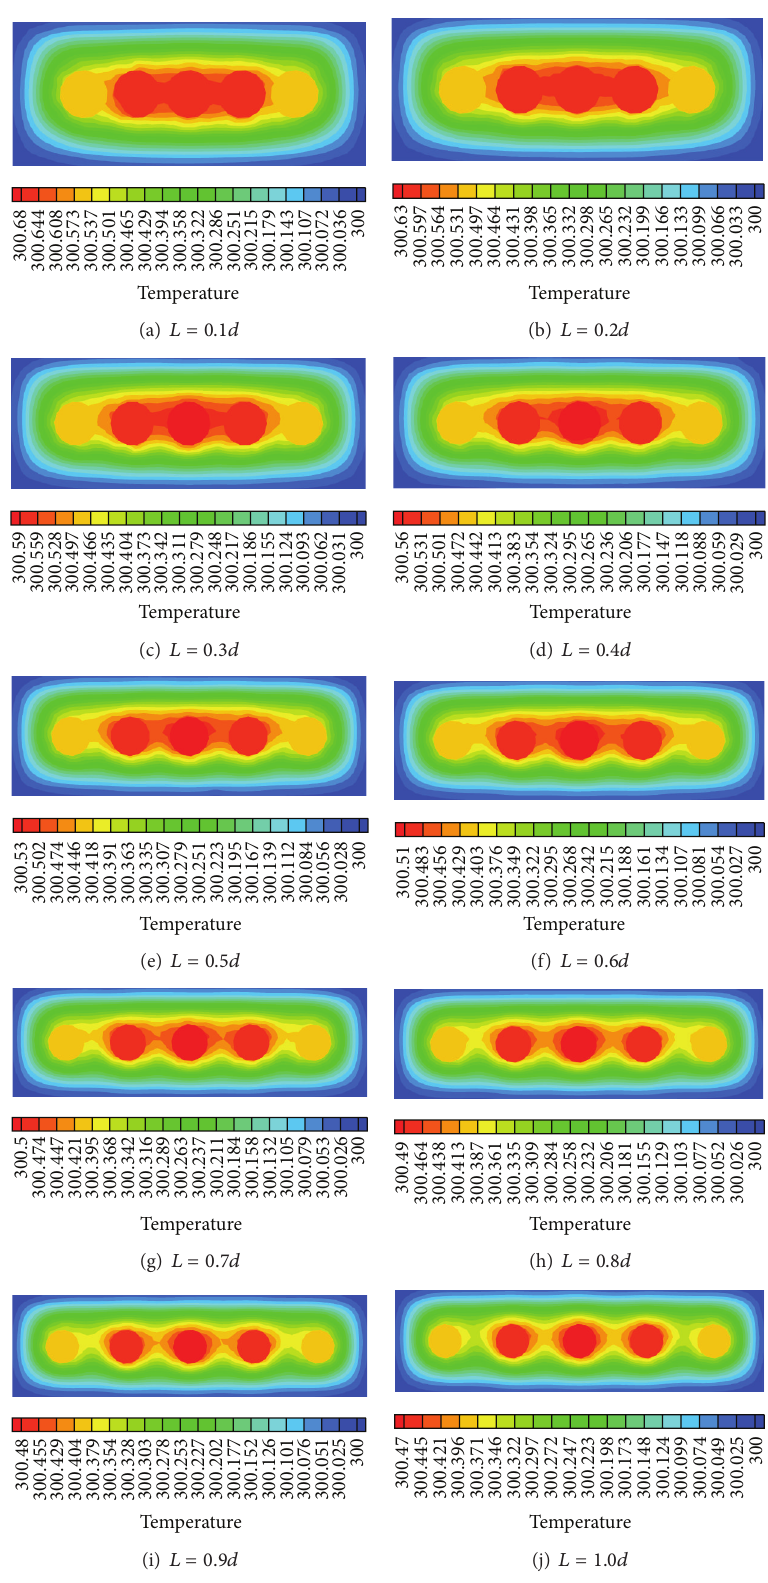
Figure 2: Temperature distribution inside the battery compartment under different spacings between